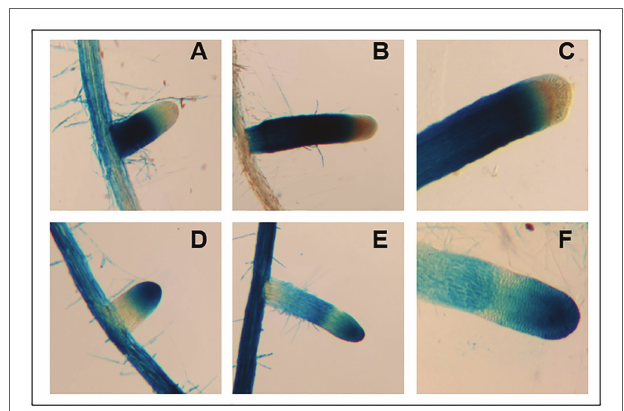
FIGURE 9 | Imaging and staining of 12-day-old AtFUT4::GUS and AtFUT6::GUS seedlings. Multiple ( n > 15) independent AtFUT4::GUS and AtFUT6::GUS plant lines are generated, grown, and observed for each construct. Visualization and qualitative analysis of GUS staining patterns of roots for two representative lines are shown. Staining patterns for lateral roots of increasing lengths are shown in (A,B,D,E) , while close-ups of tap roots are shown in (C,F) . (A,B) AtFUT4::GUS-1 , (C) AtFUT4::GUS-2 , (D,E) AtFUT6::GUS-1 , and (F) AtFUT6::GUS-2